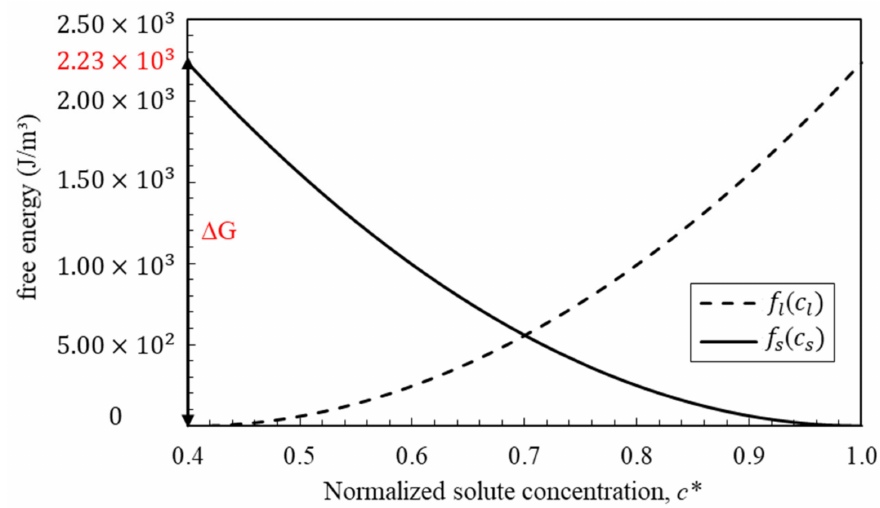
Figure A1. Variation of concentration with chemical driving